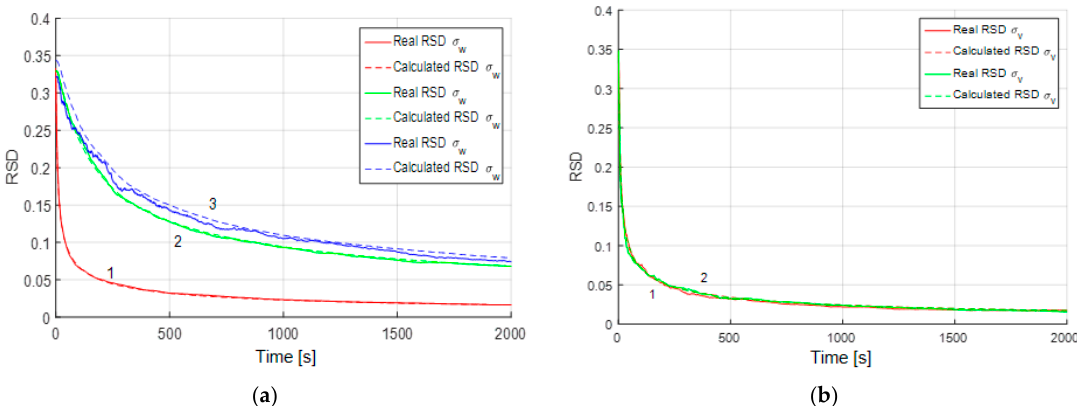
Figure 5. Real and calculated RSD for the parameters of the Markovian process: ( a ) Correlation Figure 6. ( a ) Real and calculated RSD for RMS deviation of system noise for the random walk: 1 Figure 6. ( a ) Real and calculated RSD for RMS deviation of system noise for the random walk: Figure 6. ( a ) Real and calculated RSD for RMS deviation of system noise for the random walk: 1 interval; ( b ) RMS, 1 (red) – without white-noise component, 2 (green) – with white-noise component (red)—without white-noise component, 2 (green)—with white-noise component of known RMS, 3 1 (red)—without white-noise component, 2 (green)—with white-noise component of known RMS, (red)—without white-noise component, 2 (green)—with white-noise component of known RMS, 3 of known RMS, 3 (blue) – with white-noise component of unknown RMS (3). (blue)—with white-noise component of unknown RMS; ( b ) Real (1—red) and calculated (1—red 3 (blue)—with white-noise component of unknown RMS; ( b ) Real (1—red) and calculated (1—red (blue)—with white-noise component of unknown RMS; ( b ) Real (1—red) and calculated (1—red dashed) RSD for white-noise component RMS estimates with model (21) and Real (2—green) and dashed) RSD for white-noise component RMS estimates with model (21) and Real (2—green) and dashed) RSD for white-noise component RMS estimates with model (21) and Real (2—green) and calculated (2—green dashed) RSD for white-noise component RMS estimates with Equation (22). calculated (2—green dashed) RSD for white-noise component RMS estimates with Equation calculated (2—green dashed) RSD for white-noise component RMS estimates with Equation (22).